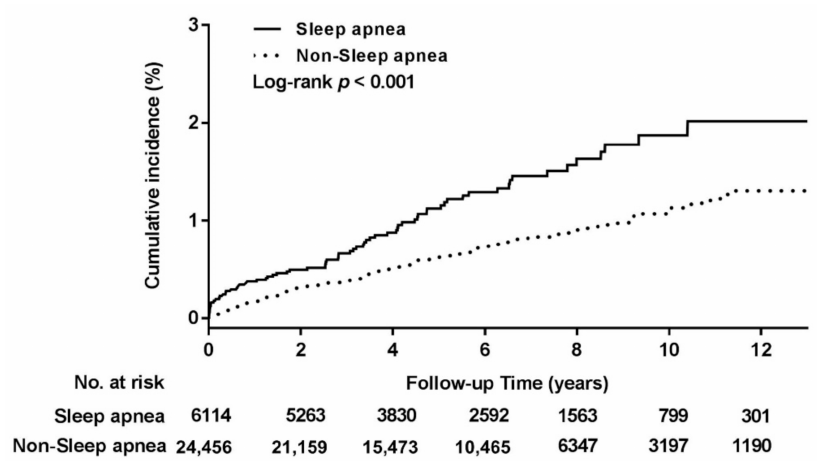
Figure 2. Cumulative incidence of deep neck infection in the study